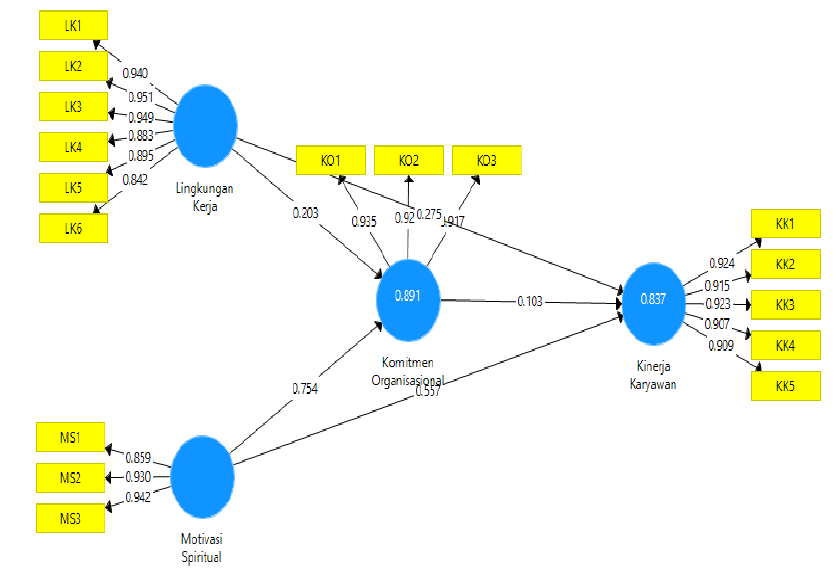
Fig. 2. Research Model Path Source: SmartPLS 3.3 Programs